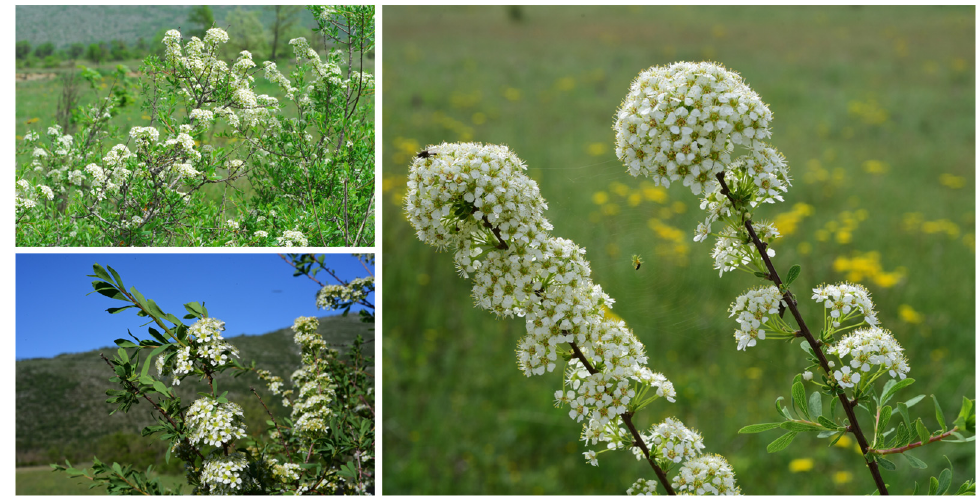
Table 1. Comparison of diagnostic morphological characters based on studied herbarium material between S. hypericifolia subsp. hypericifolia and S. hypericifolia subsp. obovata . Characters are reported as 10–90 percentiles (extreme values in brack-